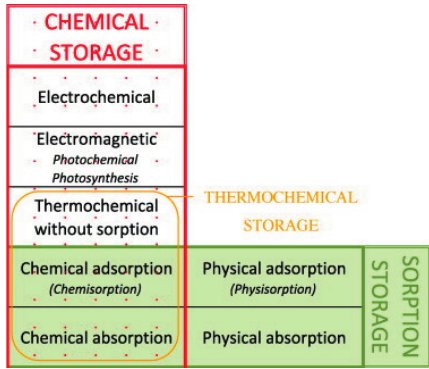
Figure 1. Chemical storage and sorption storage classification—reproduced from [19], copyright permission: Elsevier,